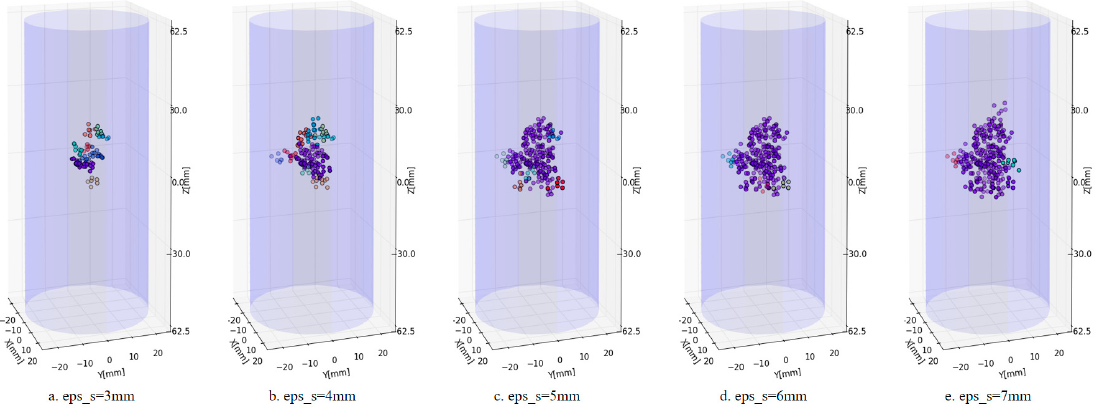
Figure 15. Calculated clusters using different Eps_s values and fixed Eps_t (200 ms), MinPts (7).